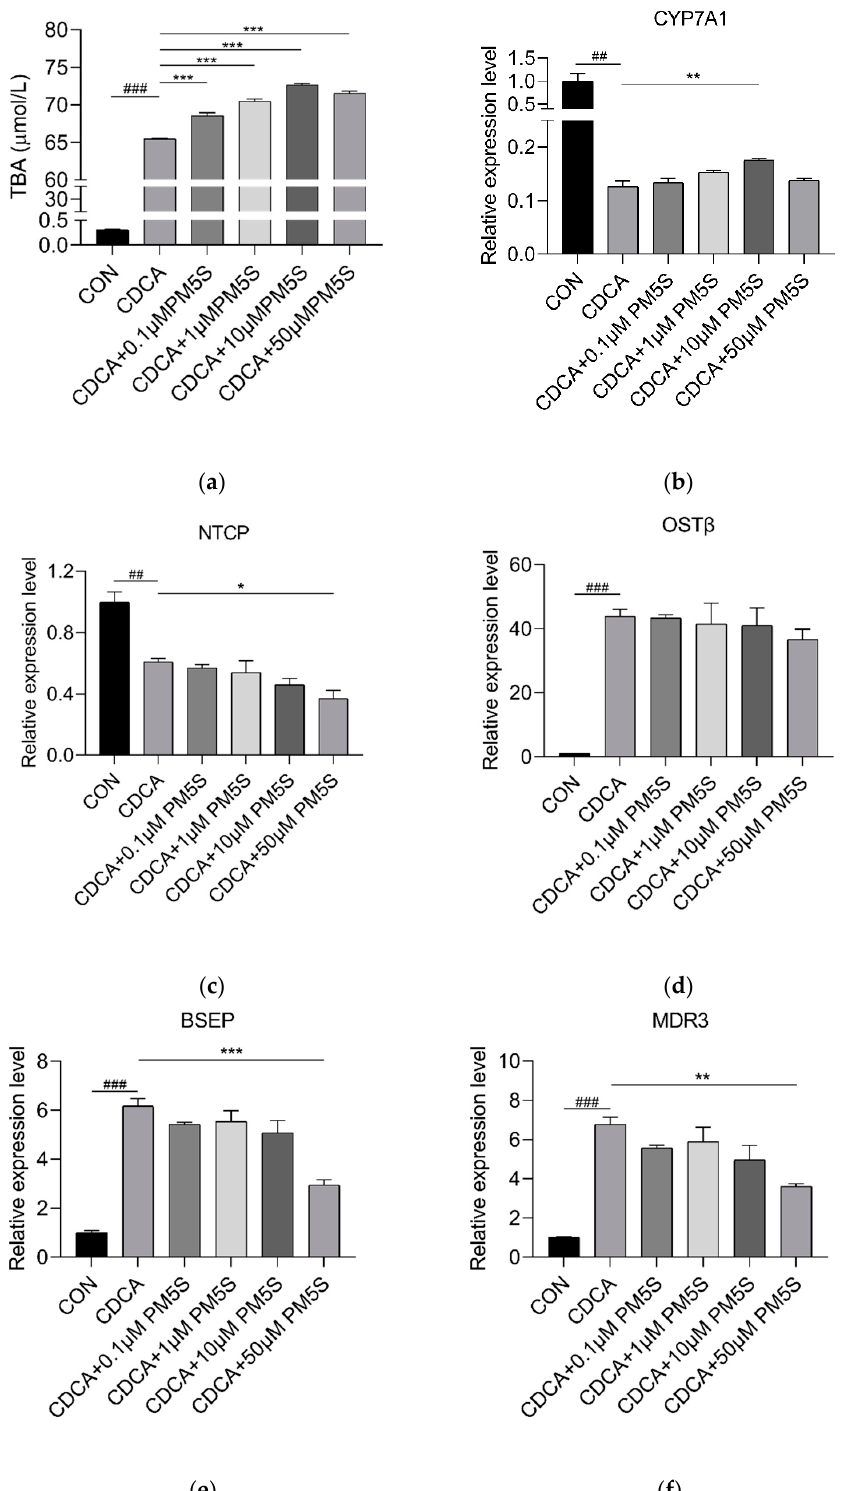
Figure 10. Relative expression of ( a ) cell medium TBA levels, ( b ) CYP7A1 , ( c ) NTCP , ( d ) OSTI ( e ) BSEP and ( f ) MDR3 in pig primary hepatocytes co-treated with CDCA (0, 50 μ mol/L) and PM5S (0, 0.1, 1, 10, 50 μ mol/L). n = 3/group. Data are shown as means ± SE, ## p < 0.01 for CON versus CDCA group, ### p < 0.001 for CON versus CDCA group. * p < 0.05 for CDCA versus CDCA and PM5S co-treatment group, ** p < 0.01 for CDCA versus CDCA and PM5S co-treatment group, *** p < 0.001 for CDCA versus CDCA and PM5S co-treatment group.